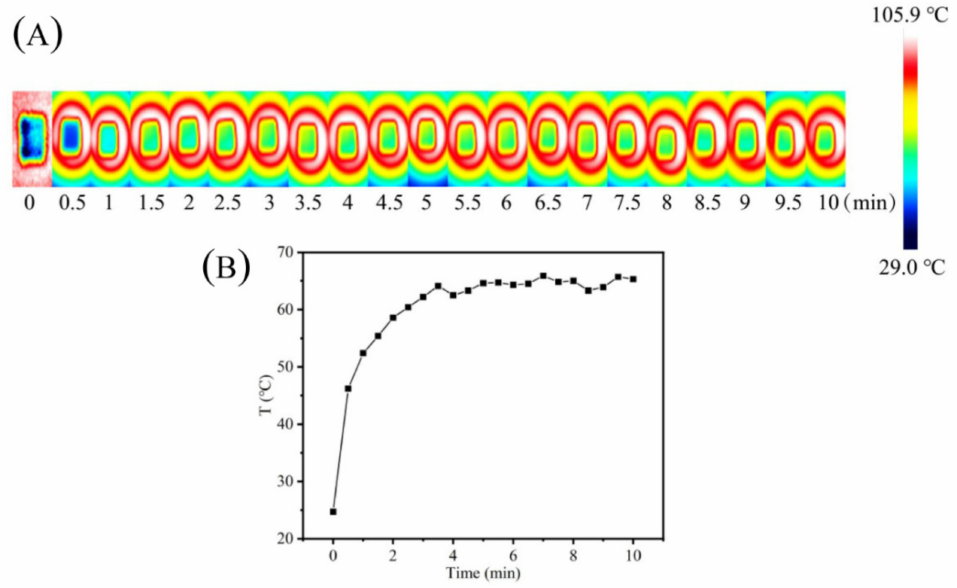
Figure 9. Infrared thermographic image of CAP agarose hydrogel under sunlight irradiation (0.65 W/cm 2 ) ( A ) and temperature variation curve ( B